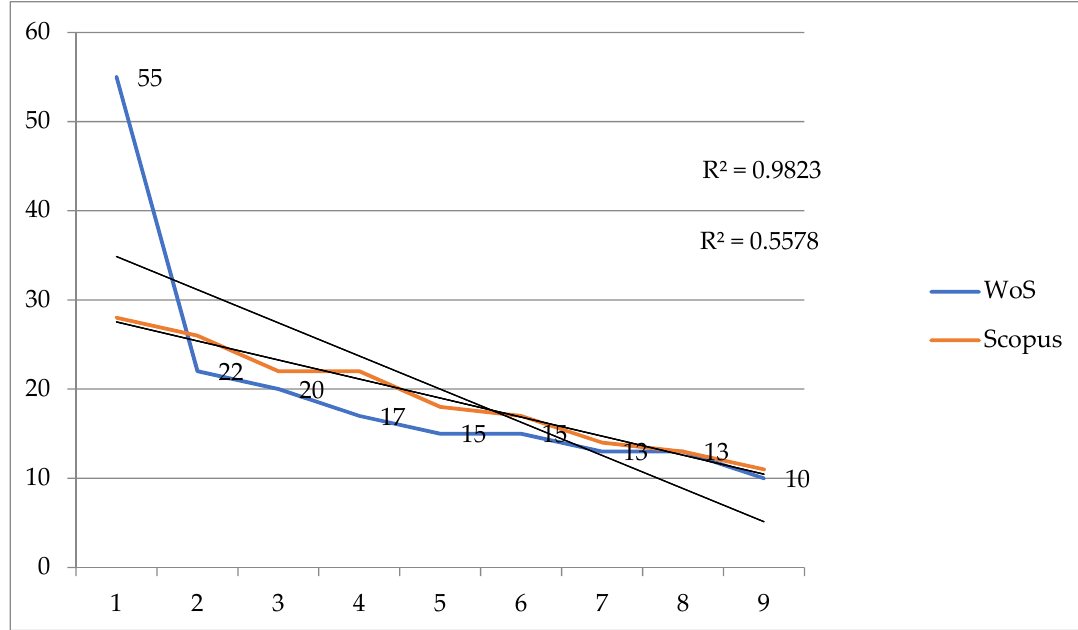
Figure 6. Dispersion of the scientific production indexed in the Web of Science and Scopus databases.